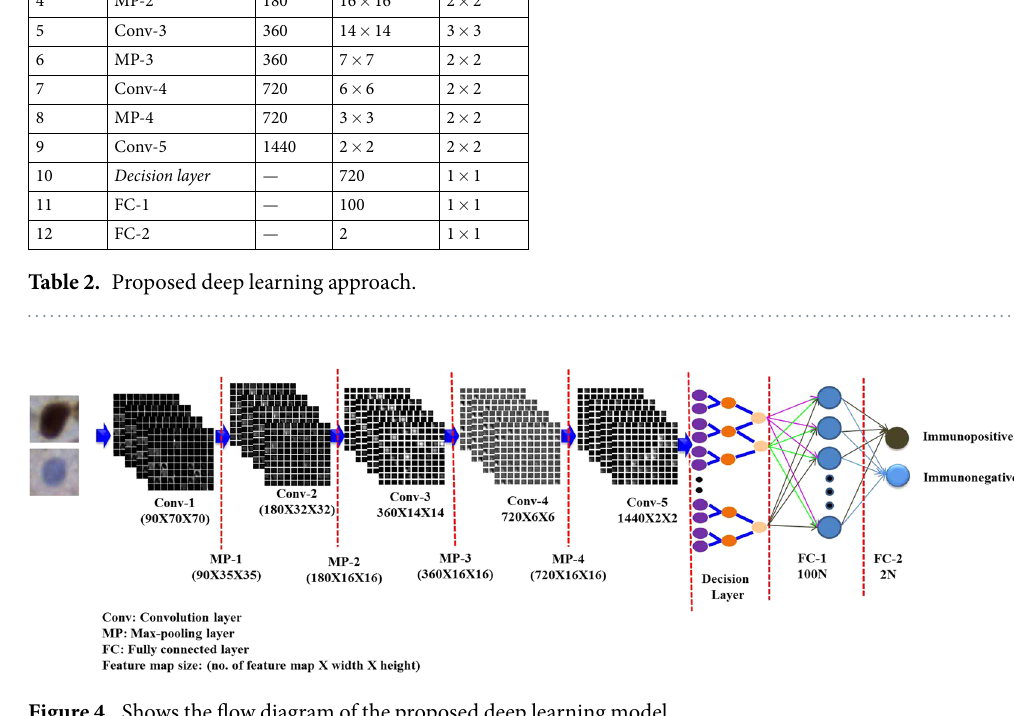
Figure 4. Shows the flow diagram of the proposed deep learning